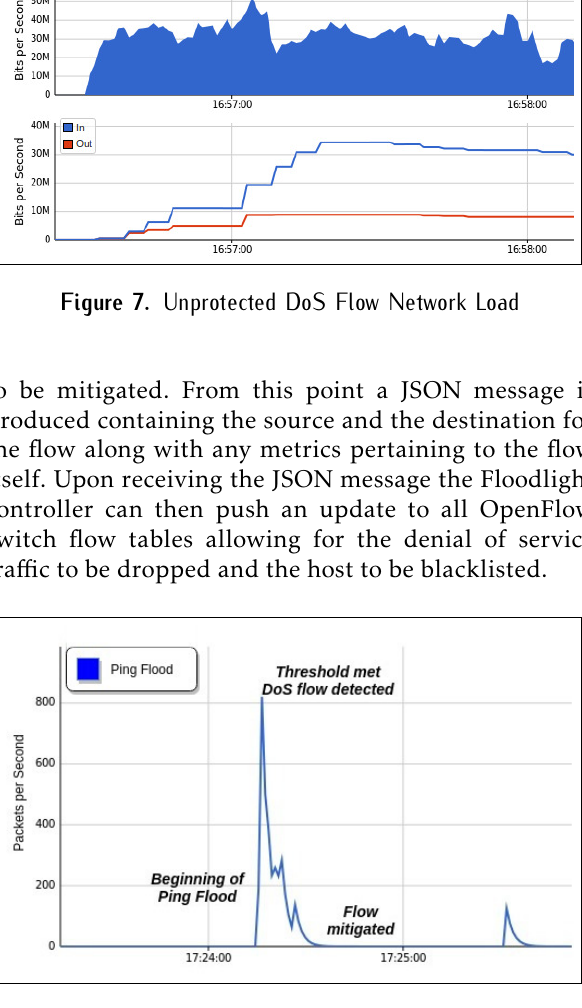
Figure 8. Protected DoS Flow